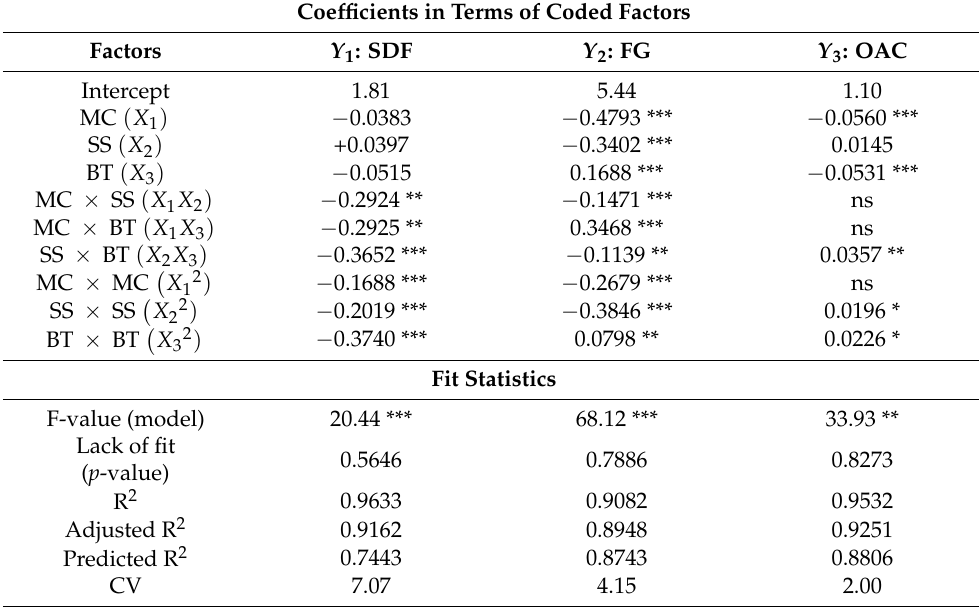
Table 2. Regression summaries for dependent